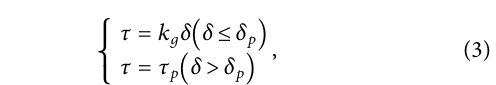
Frontiers in Earth Science |